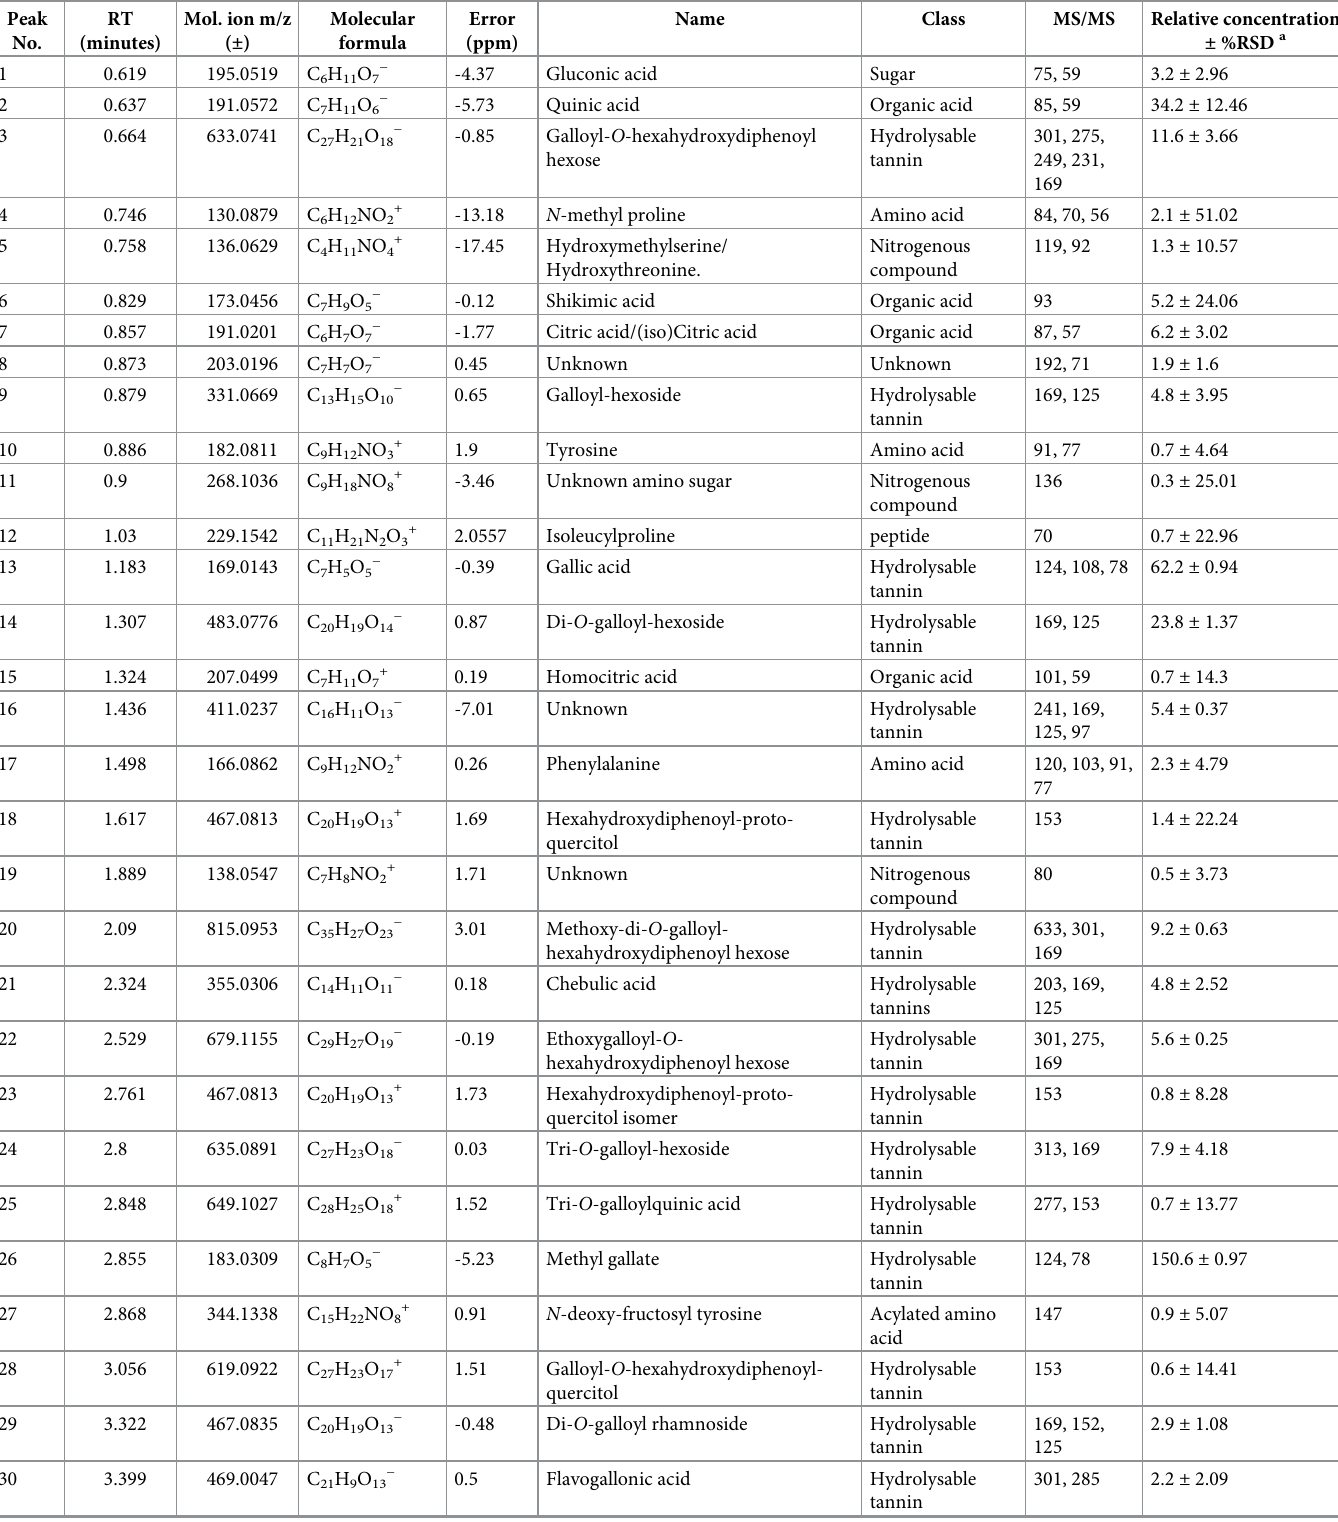
Table 1. Metabolites identified in the crude extract of S . coriaceum leaves via UPLC- ESI-QToF/MS in negative and positive ionization modes. Peak